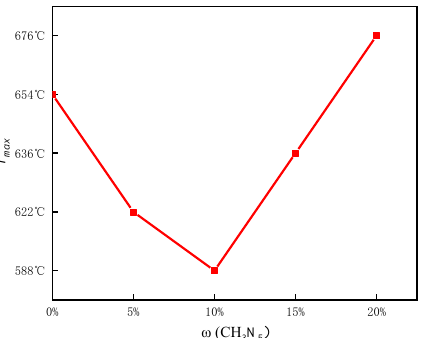
Figure 5. Variation trend of the maximum combustion temperature of samples with different 5AT mass fractions in the system.